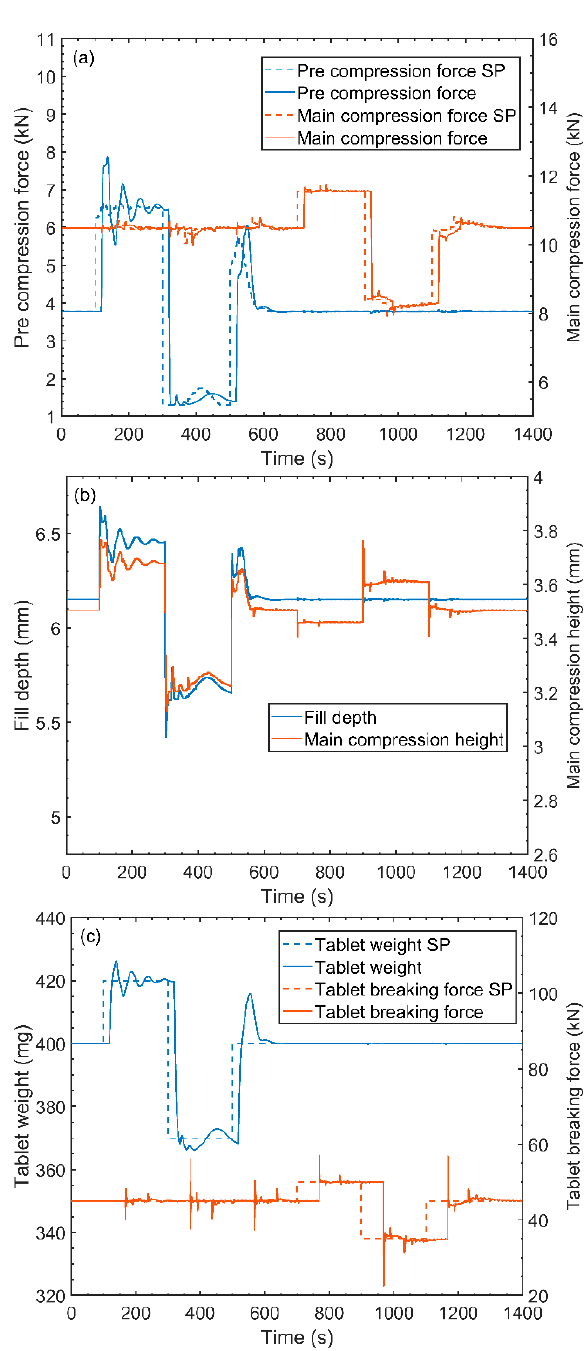
Figure 14. Control strategy 2—Set point tracking scenario. ( a ) Critical process parameters ( b ) Actuators ( c ) Critical quality attributes. SP: Set point.